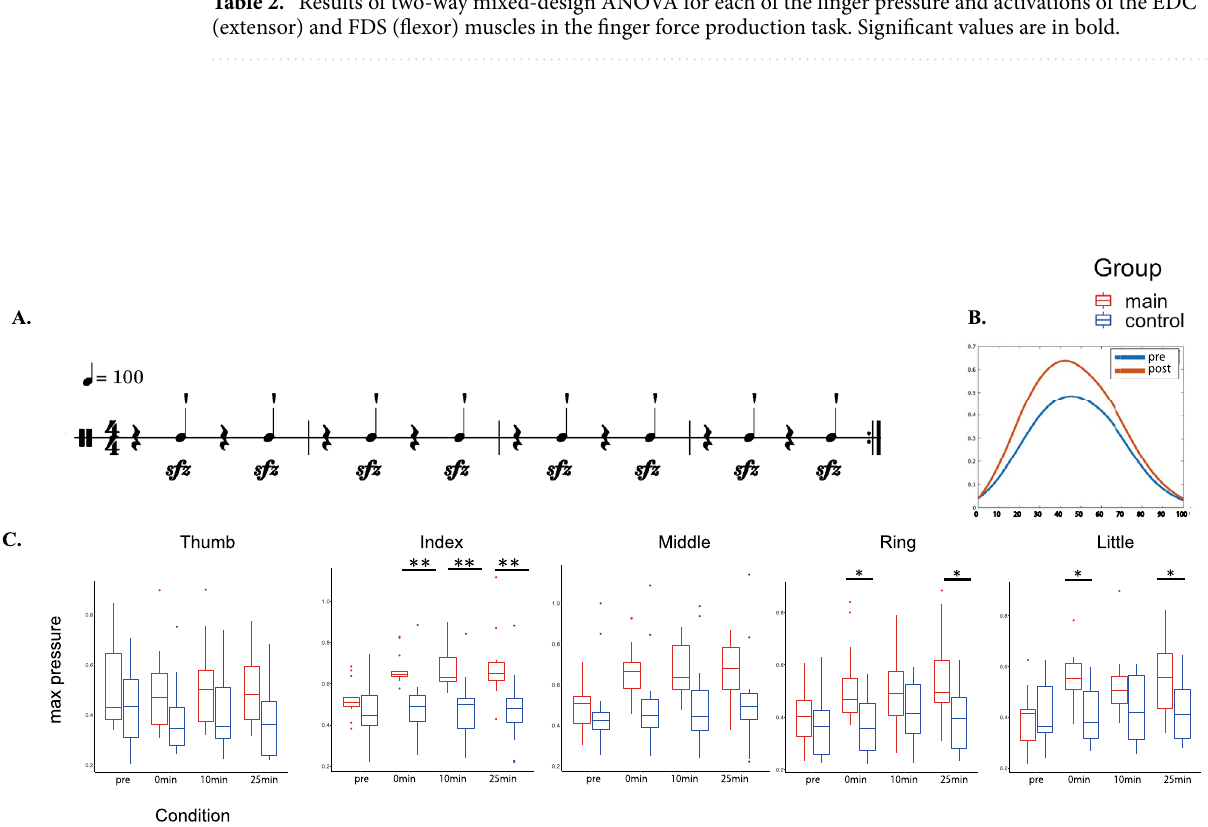
Figure 4. ( A ) A score in the finger force production test. ( B ) Representative trajectories of the finger pressure of one pianist. C: Group means of the maximum pressure exerted by each of the five digits before and after the conditioning task (x-axis; condition) in the main (red) and control (blue) groups. *p < 0.05, **p <